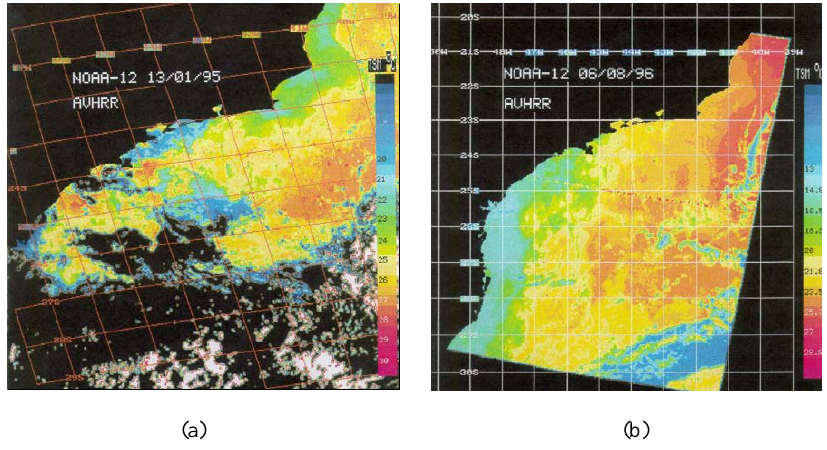
Fig. 1 Fig. 1. NOAA-12 AVHRR satellite image for: (a) day 13 January 1995, showing the coastal upwelling in the Cabo Frio region, and (b) day 6 August 1996, when the upwelling is not present in the region (values of SST higher than 23.5 ◦ C). Table 1. Days and hours (LT) when the radiosondes were launched in the COINT Project. DAY 9 January 1995 10 January 1995 11 January 1995 12 January 1995 5 August 1996 6 August 1996 7 August 1996 8 August 1996 9 August 1996